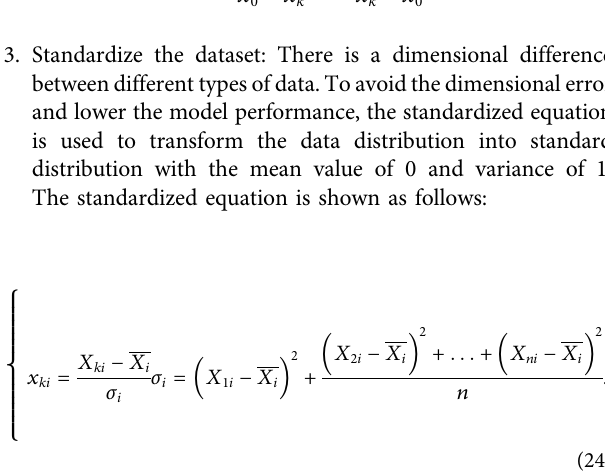
TABLE 6 | Evaluation index value of forecasting results of fi ve forecasting models.